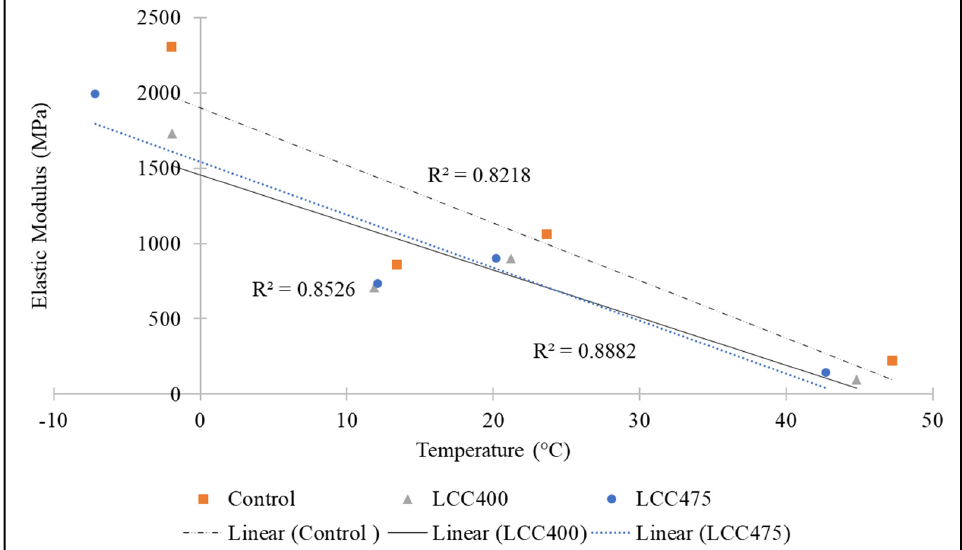
Figure 10. Sti ff ness relationship with pavement surface layer temperature. Figure 10. Stiffness relationship with pavement surface layer